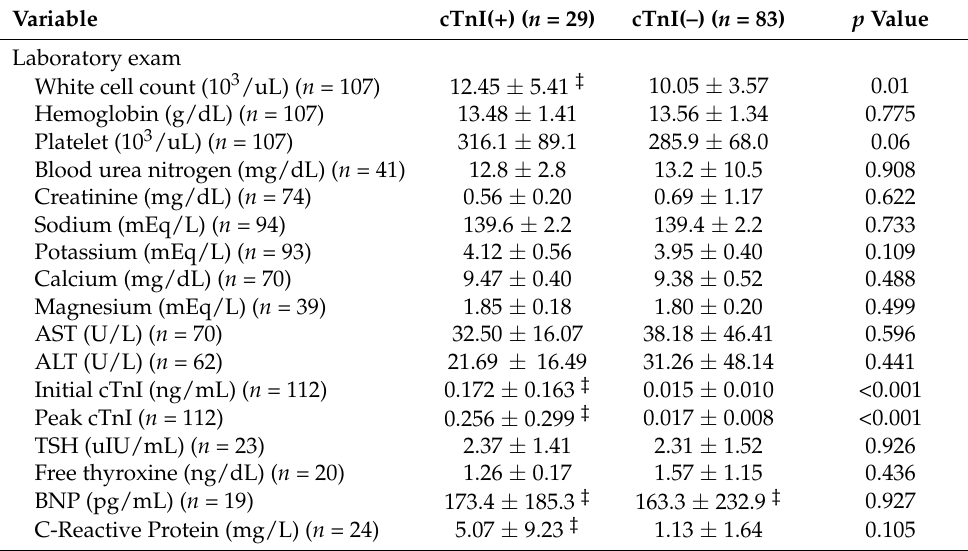
Table 2. Analysis of laboratory findings in patients with or without elevated cTnI